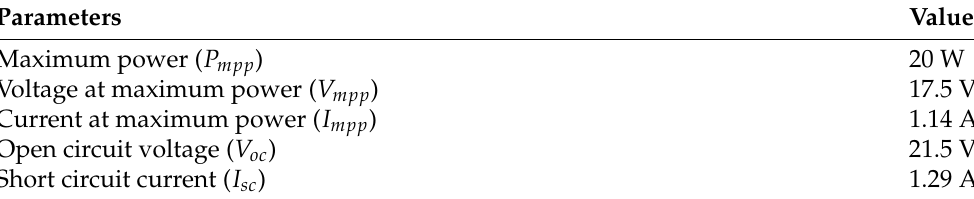
Figure 5. Concept validation scheme. Table 1. Datasheet of the SC20P-12 PV module [30].